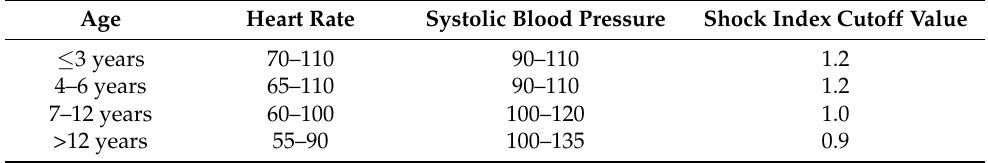
Table 1. Age-adjusted shock index cutoff